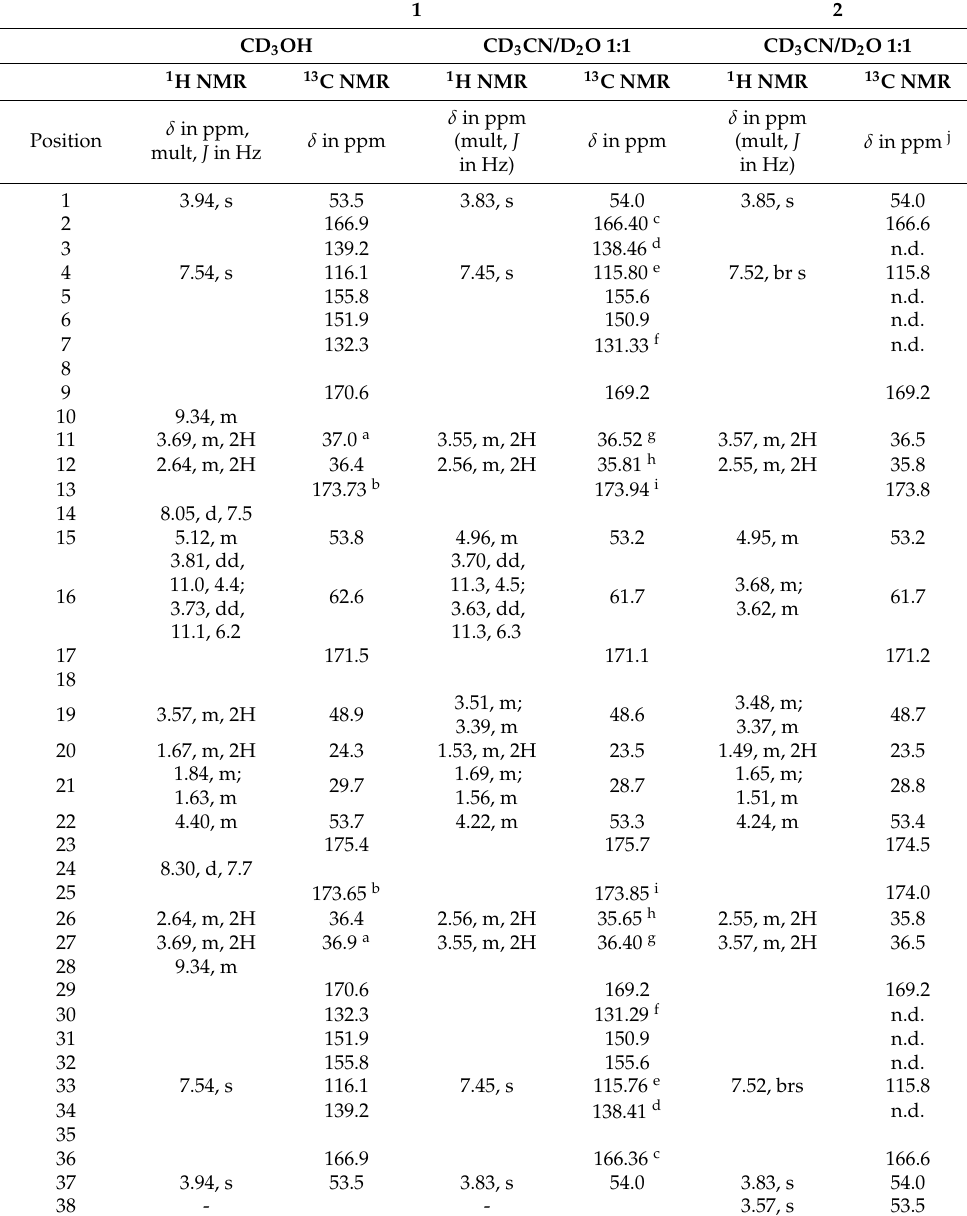
Table 2. NMR data (500 MHz) of compounds 1 and 2 . 13 C chemical shifts were obtained from HSQC and HMBC experiments. Coupling constants ( J ) indicated in